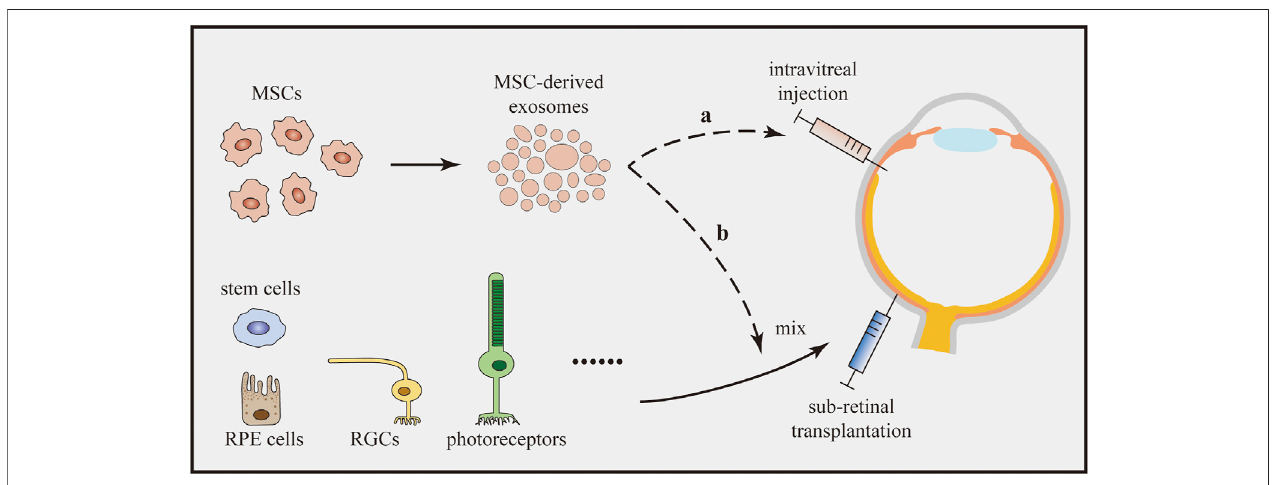
FIGURE 3 | Cotransplantation of therapeutic cells with MSC-derived exosomes. MSC-derived exosomes enhance the M2 microglial polarization and suppress retinal in fl ammation. The cotransplantation can be implemented by two options: (a) The cotransplantation can combine the intravitreal injection of MSC-derived exosomes with subretinal transplantation of therapeutic cells. (b) MSC-derived exosomes and therapeutic cells can be mixed in advance and subsequently be transplanted into the subretinal space together.